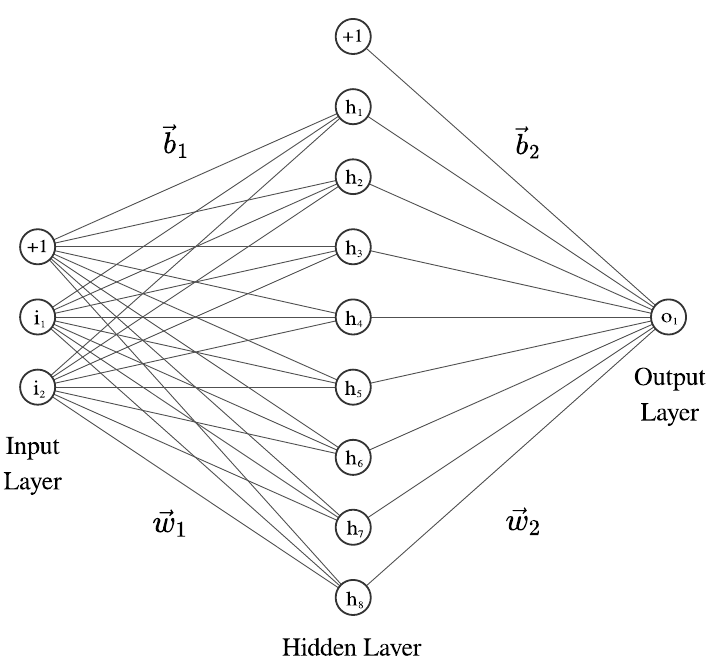
Figure 3. Perceptron built to benchmark the FSSGD algorithm; eight neurons were used to increase the number of possible conflicting solutions. The (cid:1875)(cid:4652)(cid:4652)⃗ (cid:2869) and (cid:1875)(cid:4652)(cid:4652)⃗ (cid:2870) vectors denote the weights of the connections between the input and hidden layers and between the hidden and output layers, respectively; (cid:1854)(cid:4652)⃗ (cid:2869) and (cid:1854)(cid:4652)⃗ (cid:2870) are the biases. The biases have the same dimensions as their output vectors. i (cid:2920) , h (cid:2921) , o (cid:2869) denote the neurons of the input, hidden and output layers respectively.